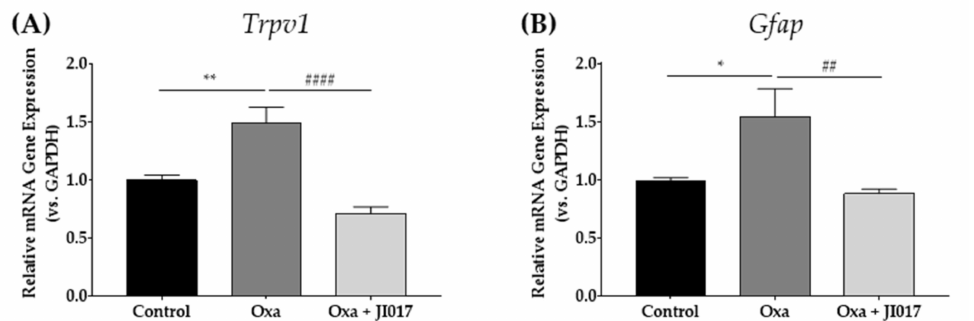
Figure 2. Changes in Trpv1 and Gfap mRNA at the spinal level. On D4 after oxaliplatin injection, changes in Trvp1 ( A ) and Gfap ( B ) mRNA levels were measured. In the oxaliplatin-treated group (Oxa), significant increase in spinal Trpv1 and Gfap was observed compared with control. Upregulated spinal Trpv1 and Gfap were recovered one hour after JI017 treatment (Oxa + JI017). Naïve mice were used as a control group ( A , B ). The Oxa group had administered PBS as a control for JI017. Control: n = 6, Oxa: n = 6, Oxa + JI017: n = 7. * p < 0.05, ** p < 0.01 vs. Control, ## p < 0.01, #### p < 0.0001 vs. Oxa with one-way ANOVA followed by Tukey’s post-test for multiple